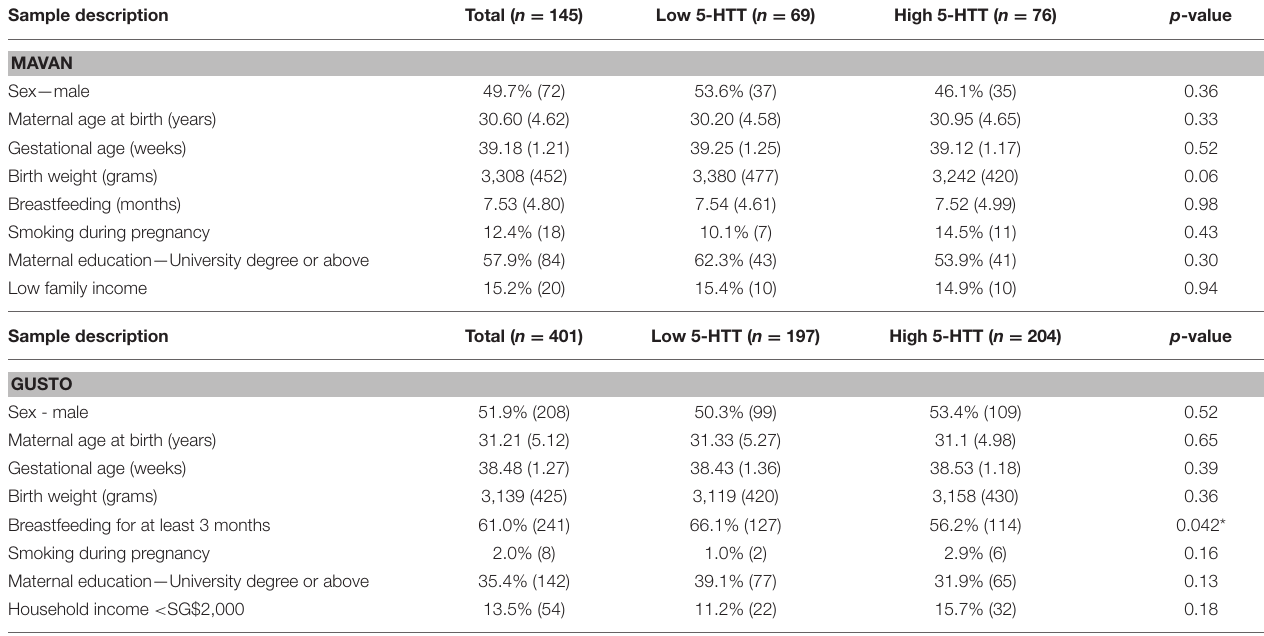
TABLE 2 | Description of the baseline characteristics of the MAVAN and GUSTO samples according to high and low amygdala ePRS-5-HTT. Sample